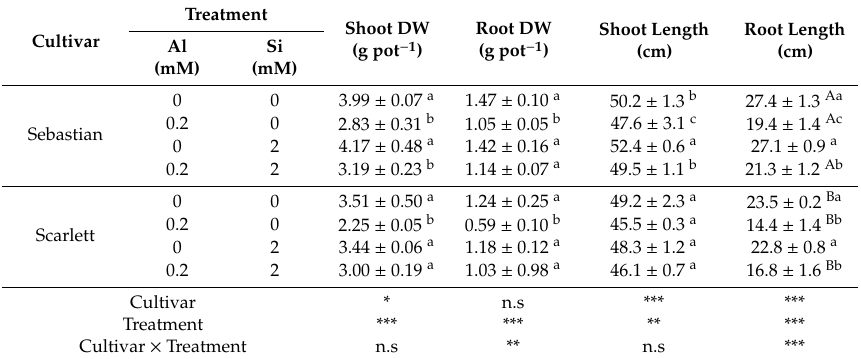
Table 1. Dry weight (DW) and length of roots and shoots of barley cultivars (Sebastian and Scarlett). Treatments were 0 or 0.2 mM Al, combined with 0 or 2 mM Si. Values represent the mean of three replicates per treatment ± SD.